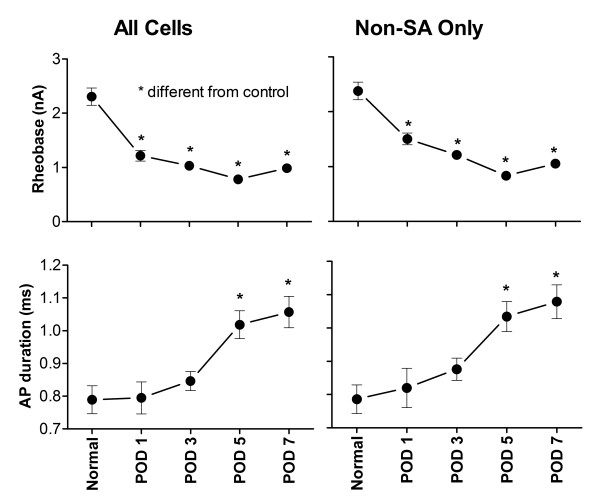
Two measures of excitability are increased in large and medium diameter mouse DRG neurons after spinal nerve ligation. *, significantly different from normal, uninjured mice. (Kruskal-Wallis One Way ANOVA on Ranks with Dunn's post test). Data is from recordings in which all cells were systematically recorded, without examining fluorescence. For spontaneously active cells, rheobase was defined as 0. Spontaneously active cells were omitted from the analysis to create the graphs on the right. Error bars (SEM) if not visible are smaller than the symbols.